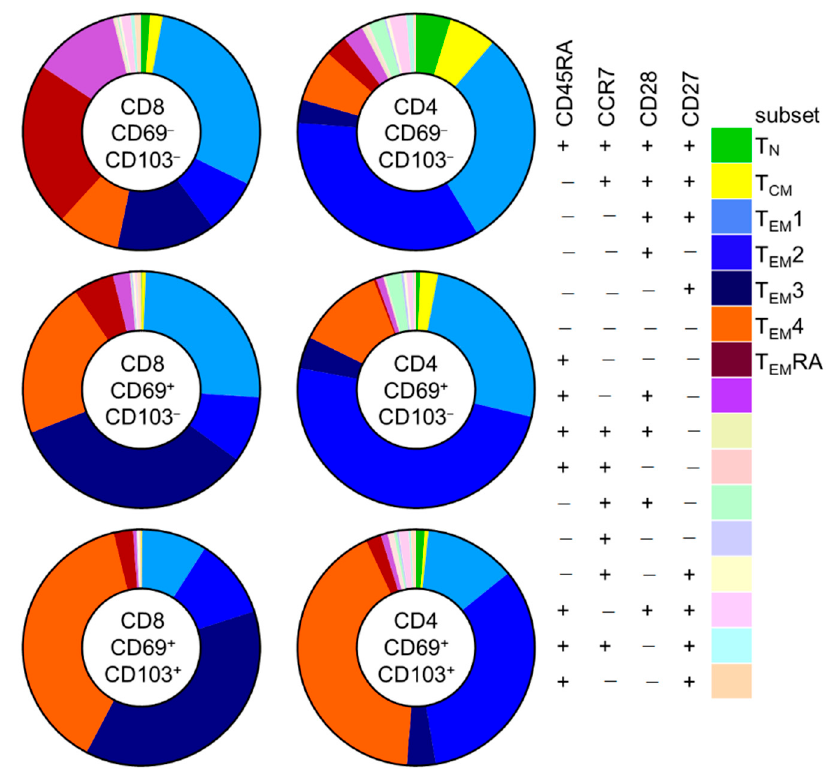
Figure 4. Memory-subset composition within CD4 and CD8 T cells from kidney changes upon CD69/CD103 co-expression. Expression patterns of CD45RA, CCR7, CD28 and CD27 within in CD69 − CD103 − , CD69 + CD103 − and CD69 + CD103 + subsets within CD8 and CD4 T cells from kidney (median).